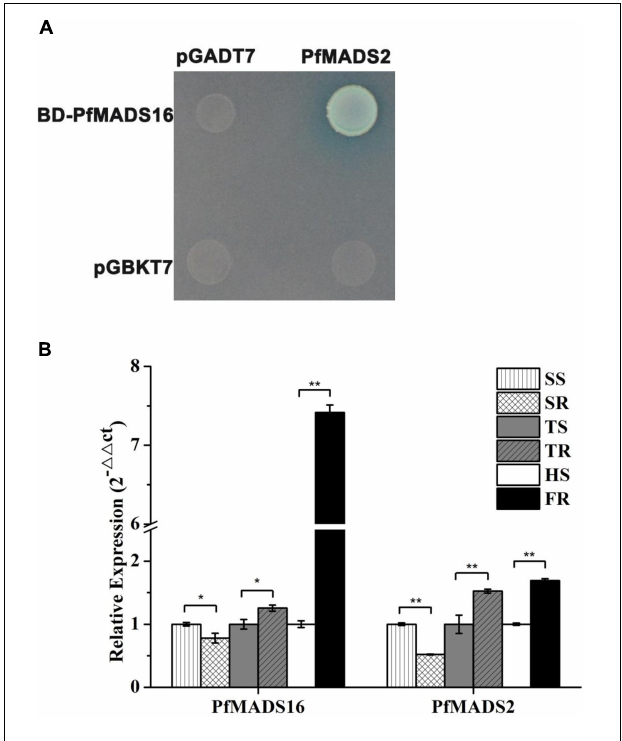
FIGURE 7 | The yeast two-hybrid and expression assays. (A) Protein interaction was indicated by the ability of yeast cells to grow on synthetic dropout medium lacking Leu/Trp/His/Ade. Genes for PfMADS16 and the interaction protein (PfMADS2) were cloned into pGBKT7 (shown as BD) and pGADT7 (shown as AD), respectively. (B) RT-qPCR analysis of PfMADS16 and PfMADS2 in the resistant population of P. fugax . * indicates significant difference, p < 0.05; ** indicates significant difference, p < 0.01. SR, Resistant plants at the seedling stage; SS, Susceptible plants at the seedling stage; TR, Resistant plants at the tillering stage; TS, Susceptible plants at the tillering stage; FR, Resistant plants at the flowering stage; HS, Susceptible plants at the heading